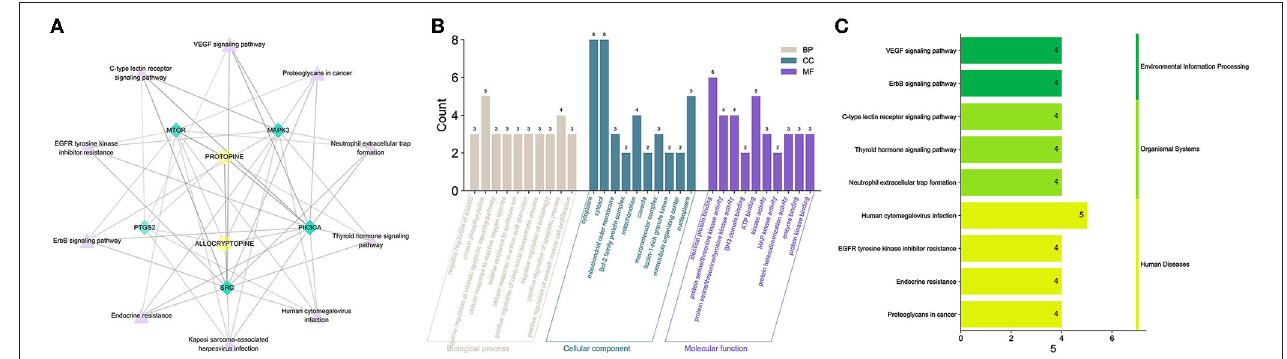
FIGURE 6 | (A) The “drug-signaling pathway-target” network of MPTA’s anti-inflammatory effects. Yellow circular nodes represent active compounds; green diamond nodes represent core targets screened; and lavender triangular nodes represent signal transduction pathways. (B) GO enrichment analysis of MPTA. The three colors represent biological processes, cellular components, and molecular functions in that order. The horizontal coordinate represents the biological function to which the core target is enriched; the vertical coordinate represents the number of genes. (C) KEGG analysis of MPTA. The horizontal coordinate represents the number of genes involved in the enrichment; the vertical coordinate represents the KEGG pathway that was enriched.